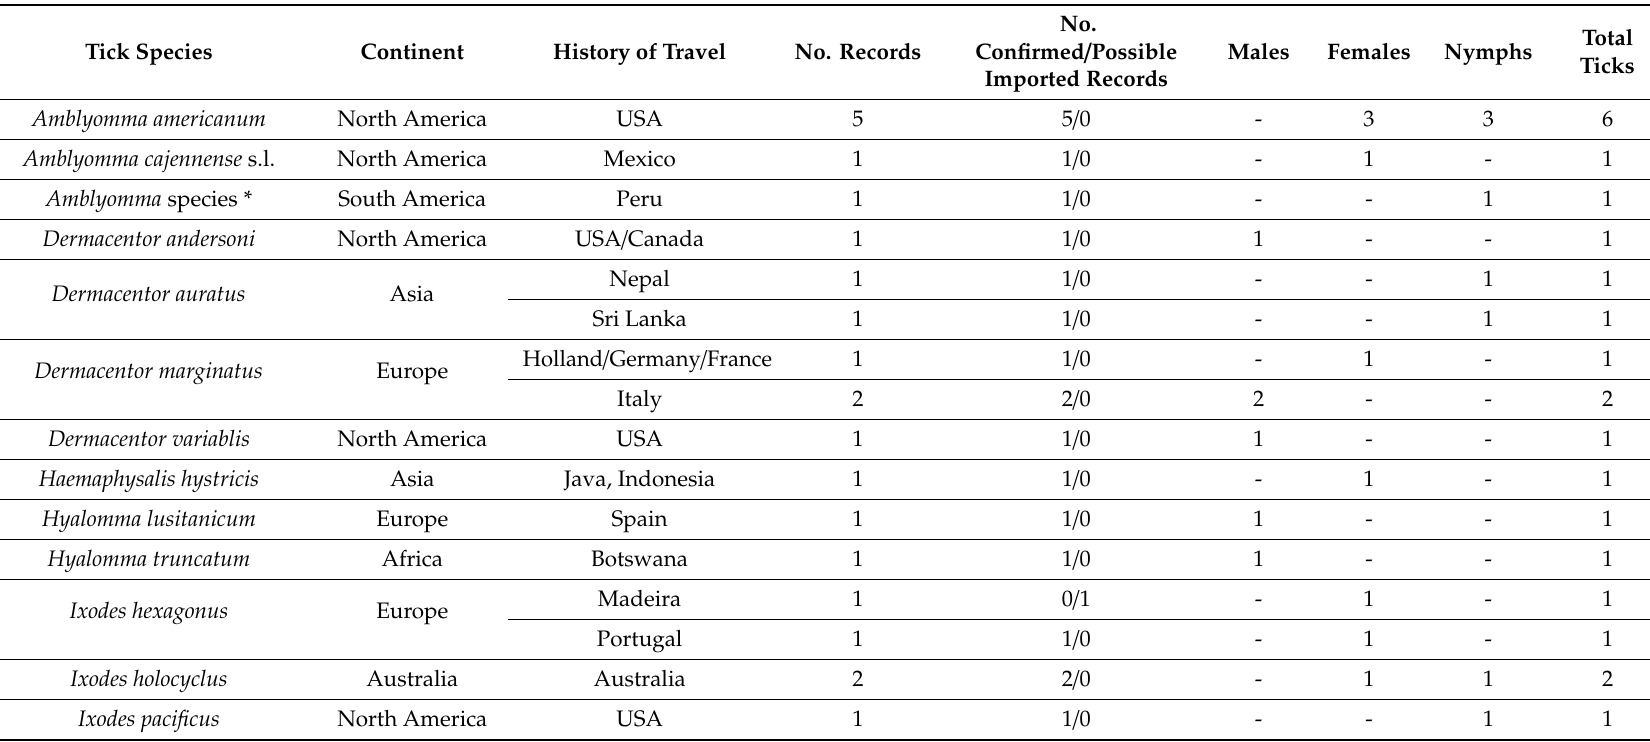
Table 1. Ticks submitted to Public Health England’s Tick Surveillance Scheme from people with recent travel history outside of the UK between 2006 and 2018. The tick species, history of travel, number of records associated with each tick species (including confirmed (C) and possible (P) imported ticks) and number of each life stage identified are shown (no larvae were